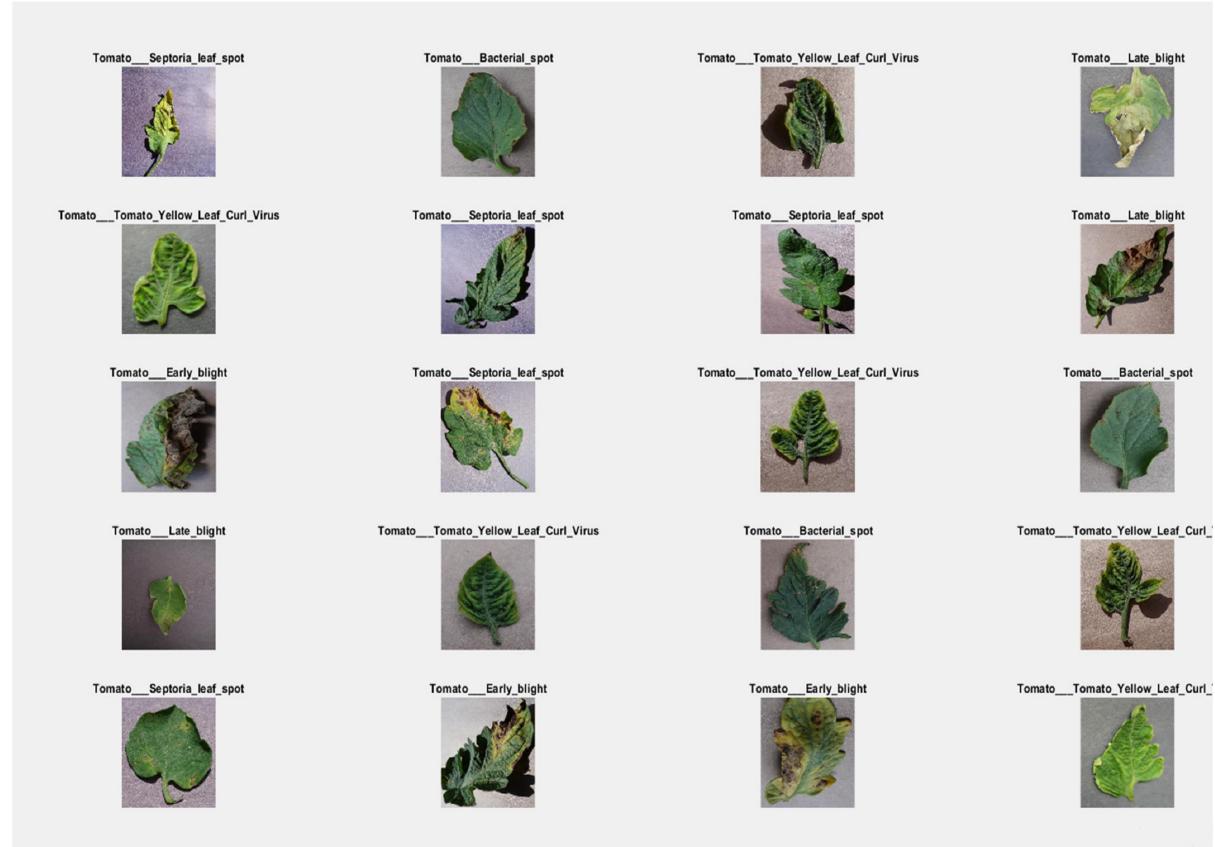
Figure 12. Visual results of Alex Net model testing result.